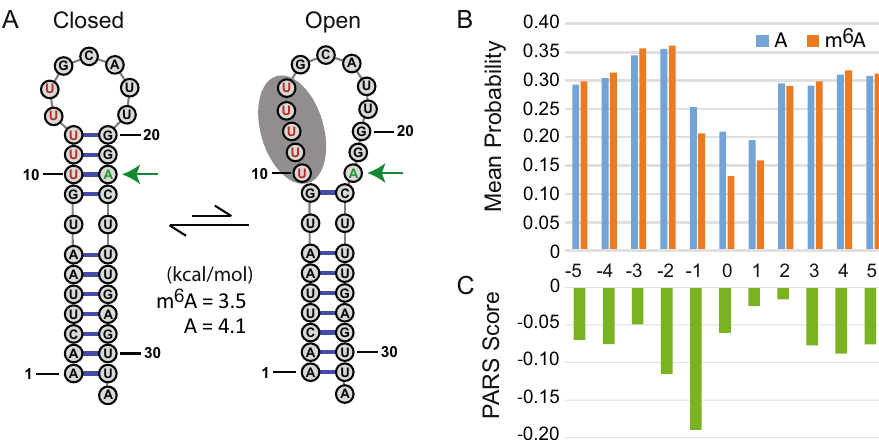
Fig. 4 Tests of the m 6 A nearest neighbor parameters and RNAstructure software. A The structure of MALAT1 RNA. The predicted secondary structure for the HNRNPC binding site is the closed conformation both with and without N 6 -methylation at A22 (green arrow). This is also supported by the NMR NOESY walk (Supplementary Fig. S4) and the similar chemical shifts for imino proton resonances with and without methylation (Supplementary Fig. S6). We model the binding of HNRNPC protein as the conformation that exposes the recognition sequence (marked in red nucleotides). When A22 is methylated to m 6 A, we estimate the cost of opening the binding site is reduced by 0.6 kcal/mol as compared to the unmethylated sequence. B The average probability that A or m 6 A are buried in a helix at the position of high-con fi dence m 6 A sites in the human transcriptome. The mean probability that an A or m 6 A is base paired and stacked between two adjacent pairs for 18,026 sites of N 6 -methylation, as estimated by RNAstructure. Position 0 is the site of methylation. N 6 -methylation is estimated to further open the structure at the methylation site. C The average PARS scores for accessibility for the 18,026 sites of N 6 -methylation in the human transcriptome. Lower PARS scores indicate higher counts of nuclease S1 cleavage relative to nuclease V1 cleavage and therefore a higher likelihood of being unpaired. The RNAstructure predictions and the PARS data both show considerable single-stranded character at the site of N 6